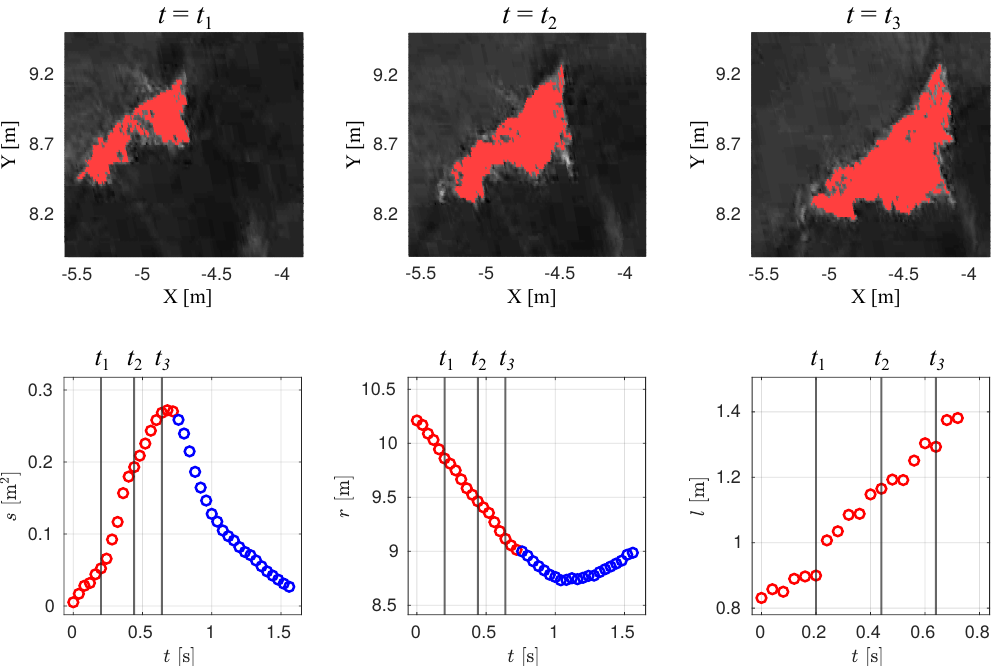
Figure 4. ( top ) A sequence of orthorectified frames with the whitecap outlined in Figure 3c. ( bottom ) The area, distance of the whitecap’s centroid from an arbitrary origin, and length of the whitecap as a function of time. Red and blue markers indicate stage A and stage B breaking, respectively. Vertical black lines show time moments corresponding to the above